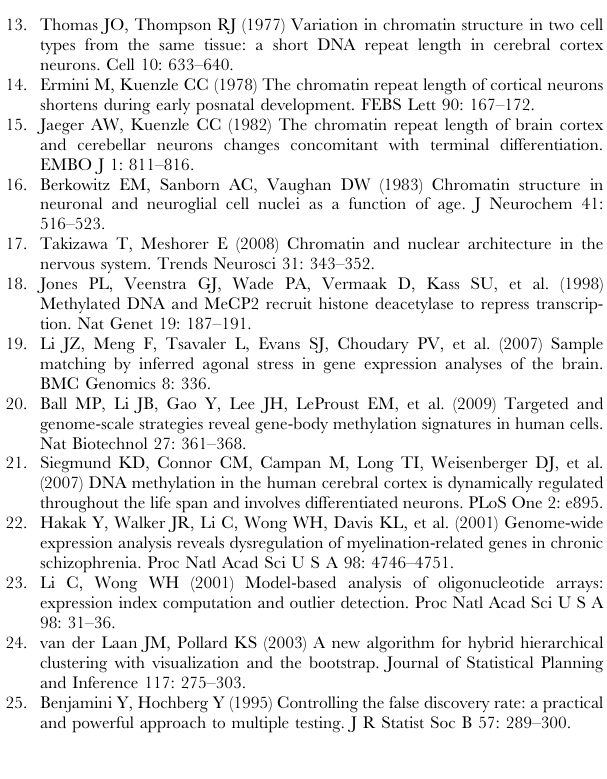
Table S2 Probes with significant differential DNA methylation in cerebral and cerebellar cortices. The table shows the MI scores of samples from prefrontal (vfrnt), occipital (occ), and temporal cortex (tmp), and the cerebellum (cer) as well as the genomic coordinate of SNP probes. Brain regions from the same subjects are color-coded. The genomic location of probes is categorized in genic (overlapping gene bodies) and inter-genic regions.